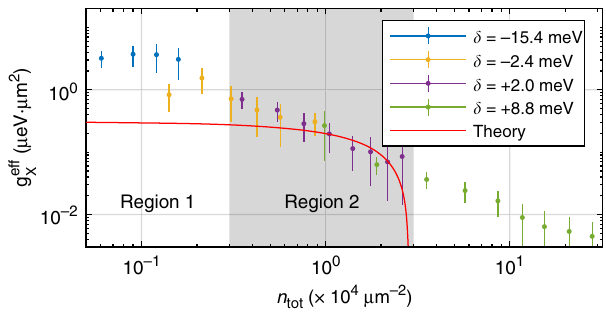
Fig. 5 Strength of nonlinearity vs pump. The experimental effective interaction constant g eff is shown as a function of the estimated exciton X density, n tot . The g eff is deduced from the energy blueshift of MPB (see X Supplementary Note 1.5). The data correspond to four different cavity – exciton detunings ( δ ): + 8.8 meV (olive), + 2.0 meV (purple), − 2.4 meV (orange), and − 15.4 meV (blue). The error bars (95% CI) are deduced taking into account errors in determining the MPB peak positions at each pump power (exciton density). The red solid curve corresponds to the theoretical